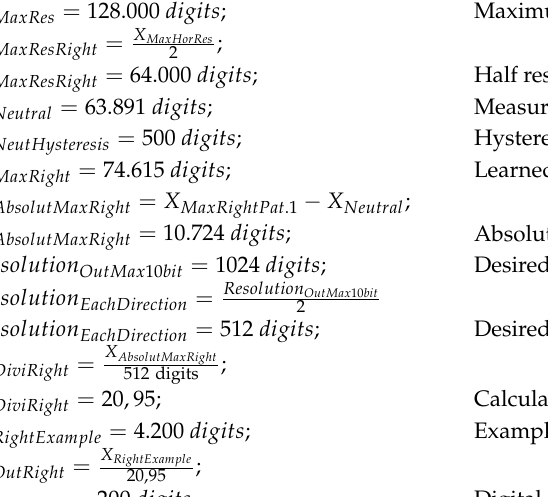
Table 4. Maximum p atient measurements and calculated output values.